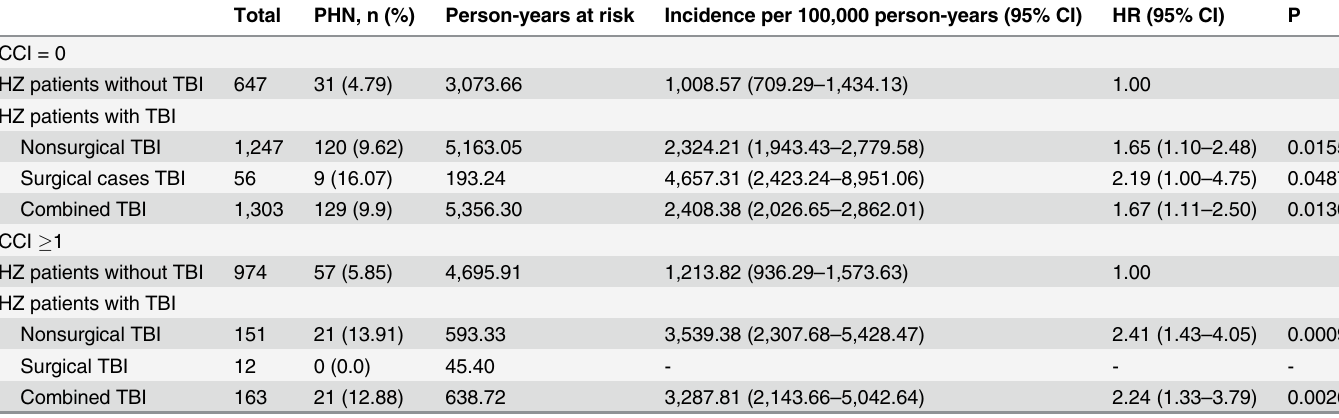
Table 5. Incidence and hazard ratios for postherpetic neuralgia during the follow-up period for herpes zoster patients with traumatic brain injury (TBI) versus without TBI with a Charlson comorbidity index = 0 or (cid:1) 1.